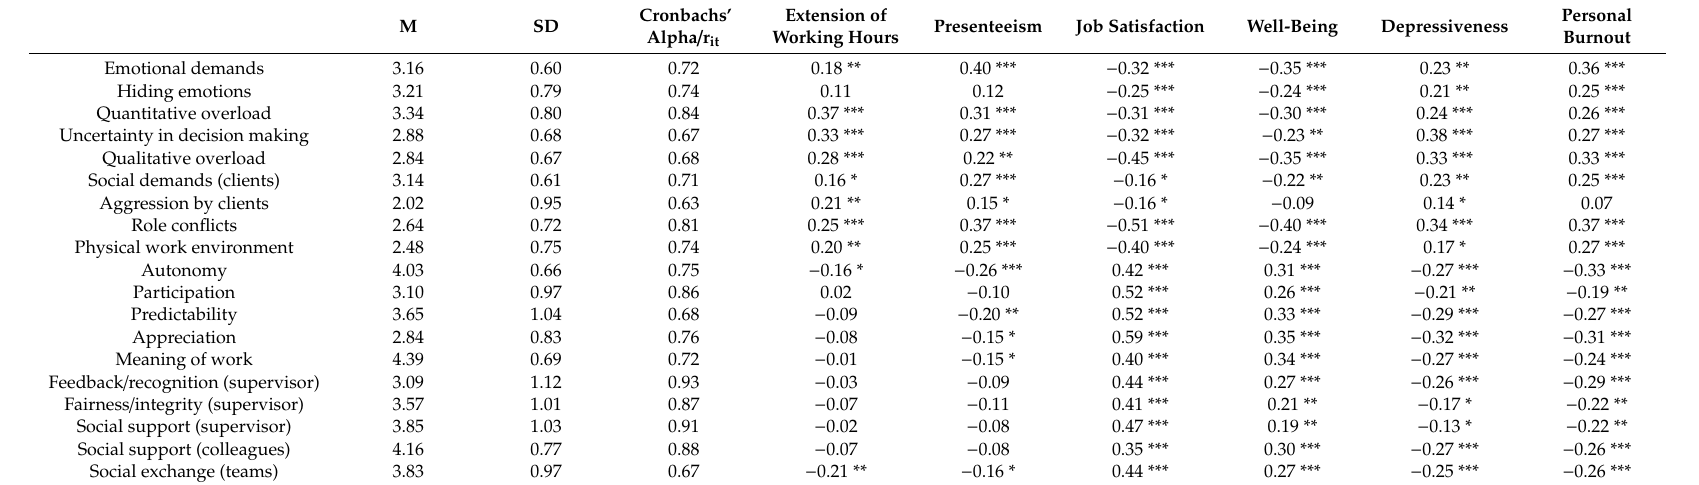
Table 2. Scale values and correlation coe ffi